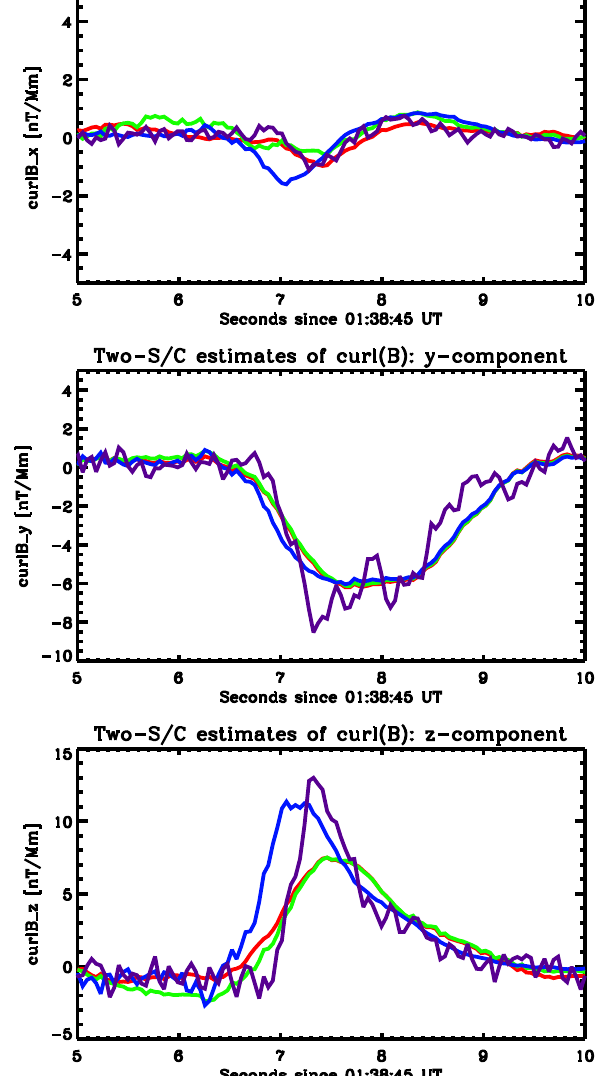
Fig. 7. Magenta: boundary curl profile − m × ˙ P derived from four- point crossing time analysis ( m : slowness vector, P : boundary field profile). Red, green, blue: curl estimates based on FGM data from the two Cluster spacecraft S/C 2 and S/C 3 on 23 January 2003, 01:38:50 UTC to 01:38:55 UTC, using the time interval 1t = 0 . 4s, for three different types of constraints, namely, (a) gradient parallel to the boundary normal unit vector (red), (b) gradient perpendicular to the (local) magnetic field vector (green), (c) force-free condition (blue). All curl profiles are given in the GSE